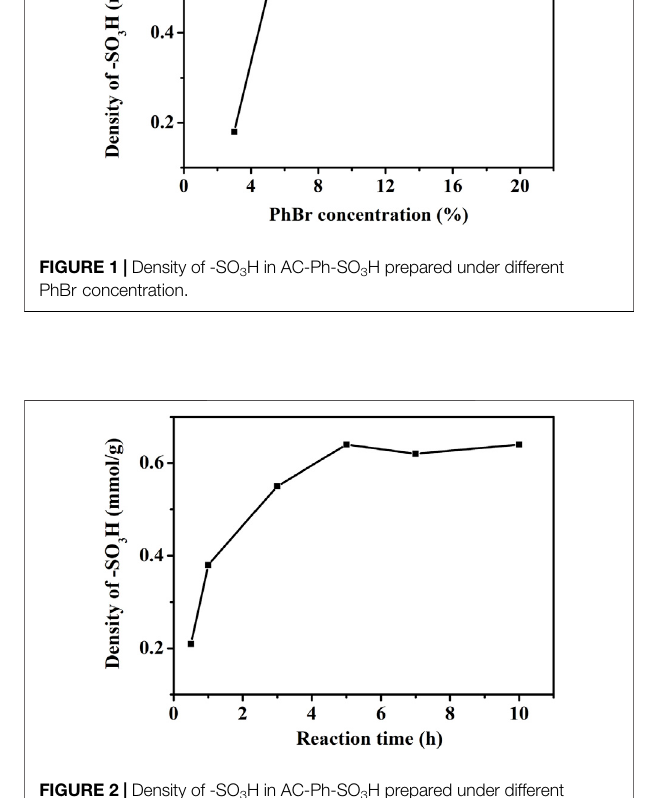
FIGURE 2 | Density of -SO 3 H in AC-Ph-SO 3 H prepared under different PhBr treated time.